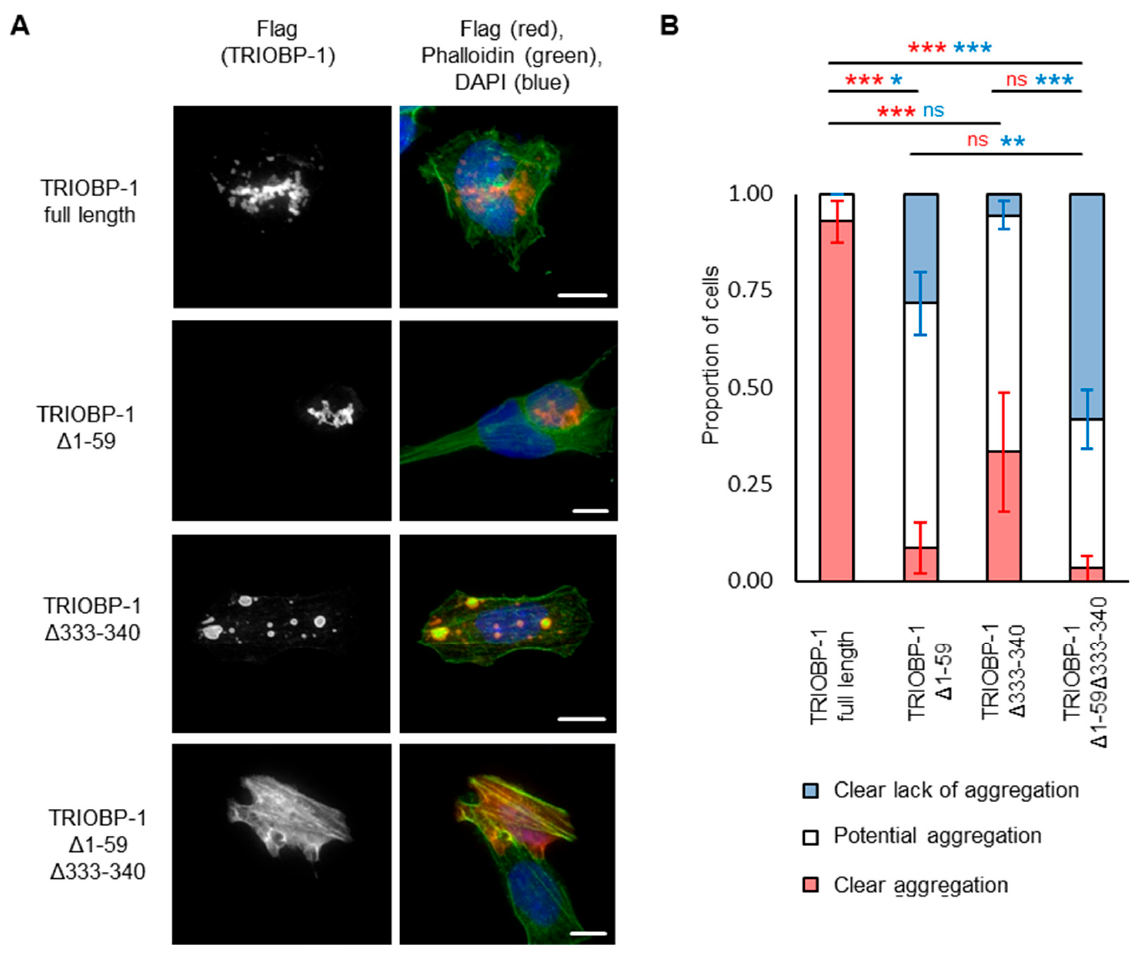
Figure 5. Both the extreme N-terminus and the central sections of TRIOBP-1 are involved in its aggregation, as shown through over-expression in neuroblastoma cells. ( A ) Full-length TRIOBP-1 lacking either the N-terminal 59 amino acid optionally translated domain or amino acids 333-340 show some signs of aggregation, while a double mutant lacking both does not. ( B ) Quantification of aggregation of these constructs in a blinded assay. Full length: n = 55 and ∆ 1-59: n = 57, ∆ 333-340: n = 30 (consistently low transfection rate), ∆ 1-59 ∆ 333-340: n = 57. For both clear aggregation (red) and clear lack of aggregation (blue): * p tukey < 0.05, ** p tukey < 0.01, *** p tukey < 0.001, ns: not significant. All images show Flag-tagged proteins are expressed in SH-SY5Y cells (except where noted) and images are typical of 3 independent experiments. The scale bars represent 10 µ m.